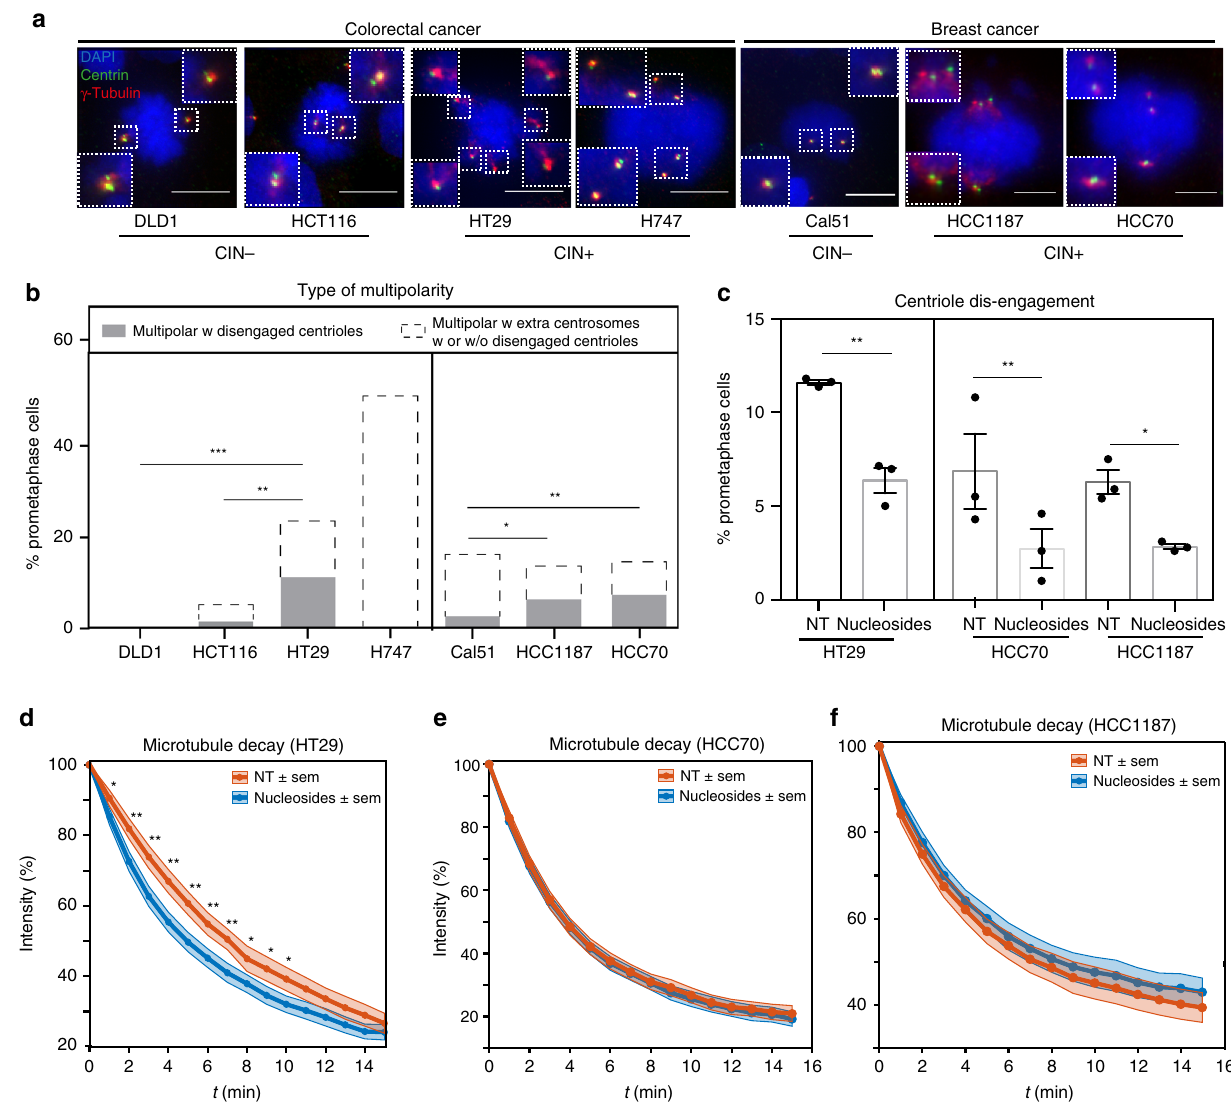
Fig. 5 CIN cancer cells present centriole disengagement. a Representative images of prometaphase DLD1, HCT116, HT29, H747 Cal51, HCC70 and HCC1187 cells stained with antibodies against centrin (green), γ -tubulin (red) and DAPI (blue); scale bars = 10 μ m. b Percentages of prometaphase cells with multipolar spindle with either premature centriole disengagement (grey) or extra centrosomes (white) in indicated cell lines; N = 93 prometaphase cells for DLD1, 92 for HCT116, 81 for HT29, 91 for H747, 203 for Cal51, 323 for HCC1187 and 359 for HCC70; p < 0.0001 in a chi-square test (DLD1 vs. HT29 p = 0.001, HCT116 vs. HT29 p = 0.0048, H7474 vs. HT29 p = 0.0011, Cal51 vs HCC1187 p = 0.0214 and Cal51 vs HCC70 p = 0.0066). c Mean per c entage of prometaphase HT29, HCC1187 and HCC70 cells with premature centriole disengagement with or without a 20 μ M nucleosides supplement; N = 3 examining NT/HT29 = 138, nucleosides/HT29 = 125; NT/HCC1187 = 323, nucleosides/HCC1187 = 350, NT/HCC70 = 359 and nucleosides/ HCC70 = 350 prometaphase cells; p < 0.0001 in two-way Anova test. (HT29 p = 0.002, HCC1187 p = 0.0158 and HCC70 p = 0.0065). d – f Quanti fi cation of the spindle intensity over time after a nocodazole pulse, as shown in Fig. 2d, in metaphase HT29 ( d ), HCC70 ( e ) or HCC1187 cells ( f ) supplemented with or without nucleosides; N = 33 for HT29/NT and 23 for HT29/nucleosides, 74 for HCC70/NT and 55 for HCC70/nucleosides, 74 for